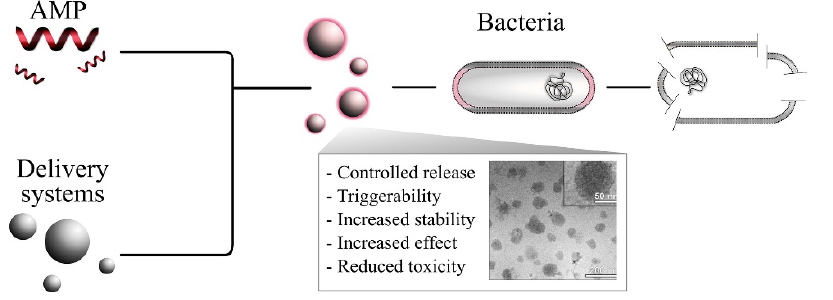
Figure 6. The development of advanced delivery systems for AMPs can be advantageous. Reprinted with permission from Ref. [124]. Copyright 2017 Elsevier.